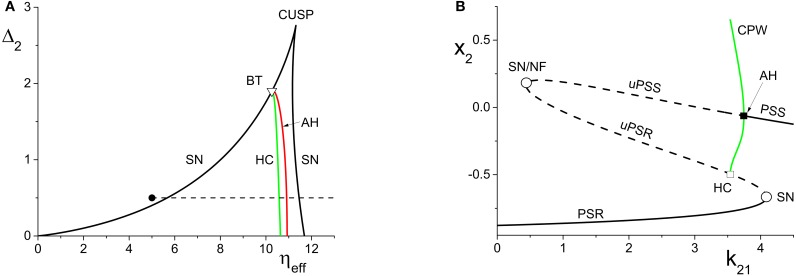
(A) The two-dimensional bifurcation diagram of the inhibitorily-coupled response system. The heavy black lines are saddle-node (SN) bifurcation curves, green is a homoclinic (HC) bifurcation curve, and red is an Andronov-Hopf (AH) bifurcation curve. The latter two curves emerge from a Bogdanov-Takens (BT) point. The solid dot denotes the parameters of the response system when decoupled from the driver. In the cases considered in the main text, the driver causes ηeff to vary along the horizontal dotted line. The parameters are: η1 = −0.2, Δ1 = 0.1, k11 = −2, and k22 = −9. (B) The one-dimensional bifurcation diagram showing the asymptotic value of x2 = Re(z2) vs. k21. Solid curves denote stable equilibria; dashed black curves are unstable equilibria. Green represents the maxima and minima of a collective periodic wave (CPW) limit cycle. The parameters are as in (A), with η2 = 5 and Δ2 = 0.5.